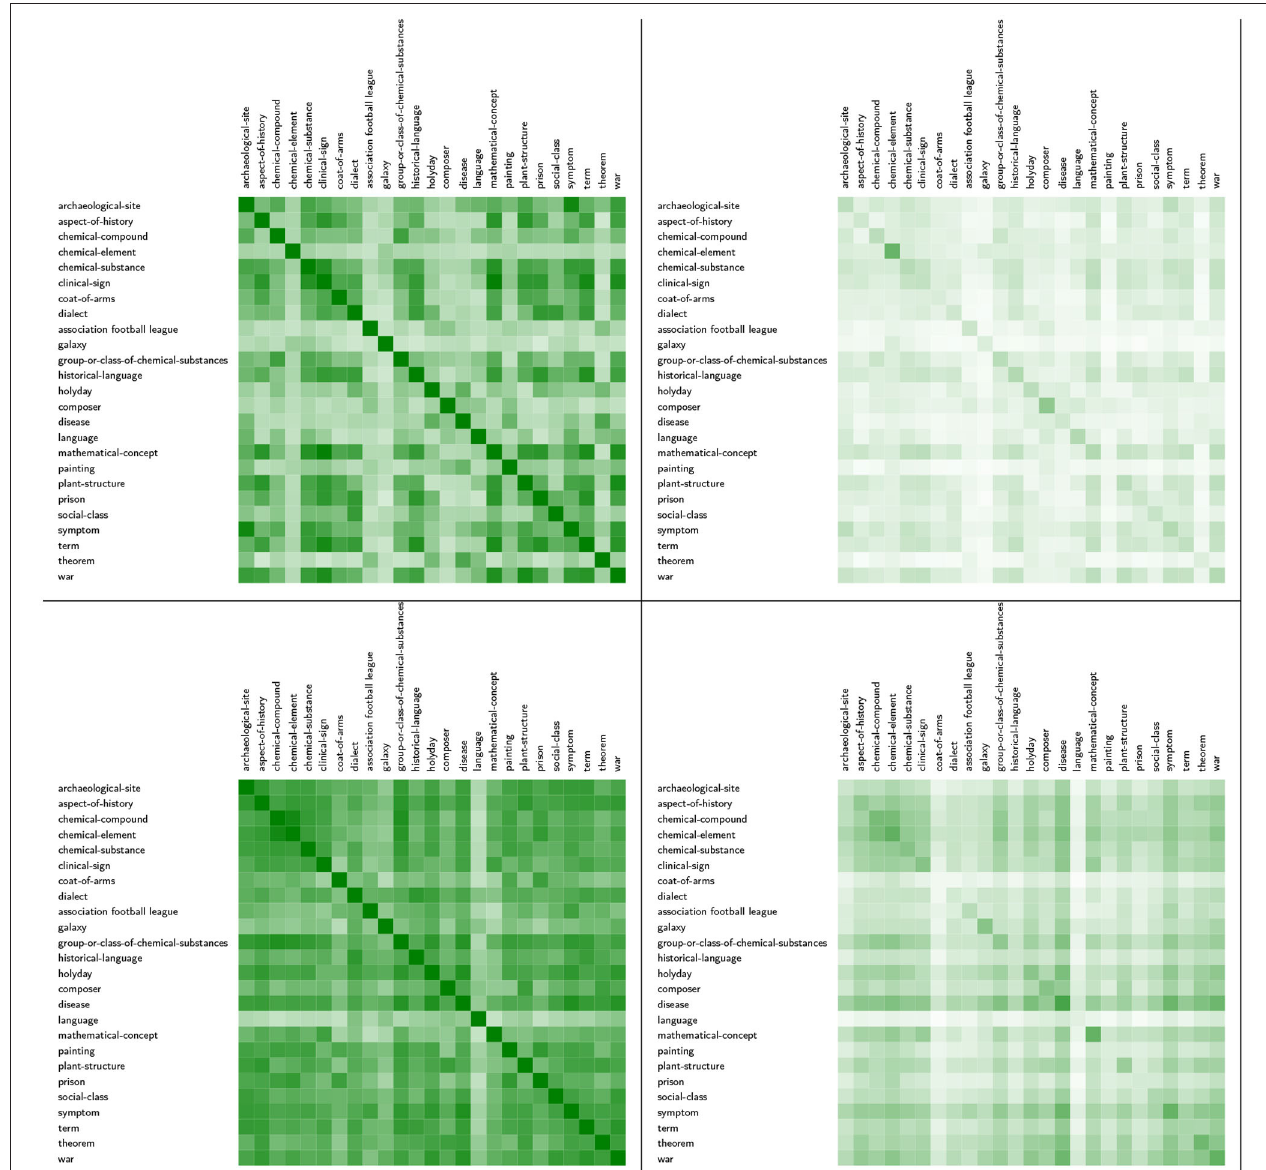
FIGURE 13 | From left to right: Unweighted and weighted distance correlations of the centralities of 35 languages in 25 language networks. First row: GES; second row: SV2.